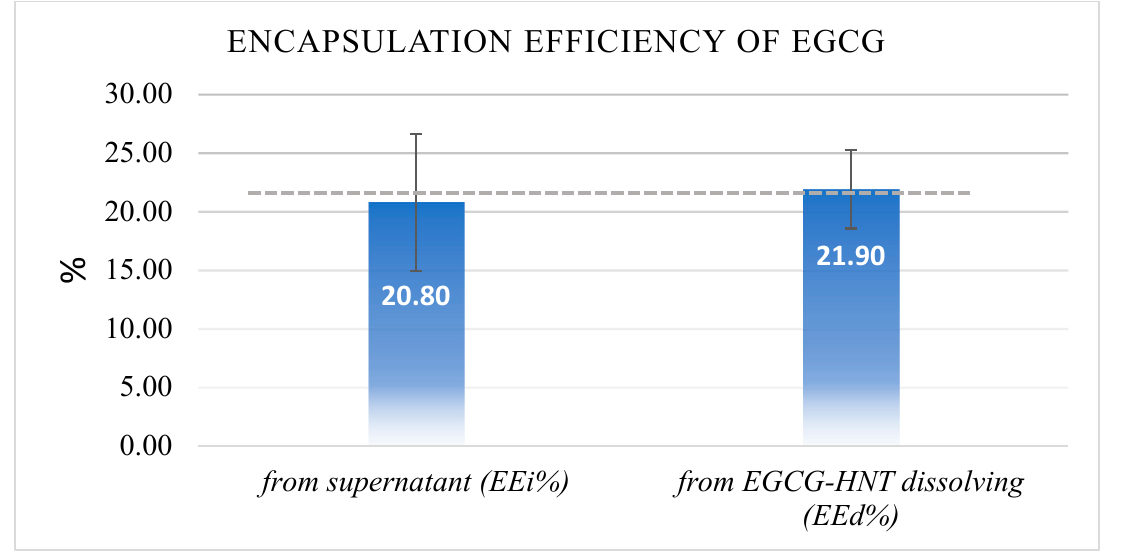
Figure 2. Encapsulation efficiency results of the EGCG detected in the supernatant (unloaded) and dissolved EGCG-encapsulated HNTs (loaded).